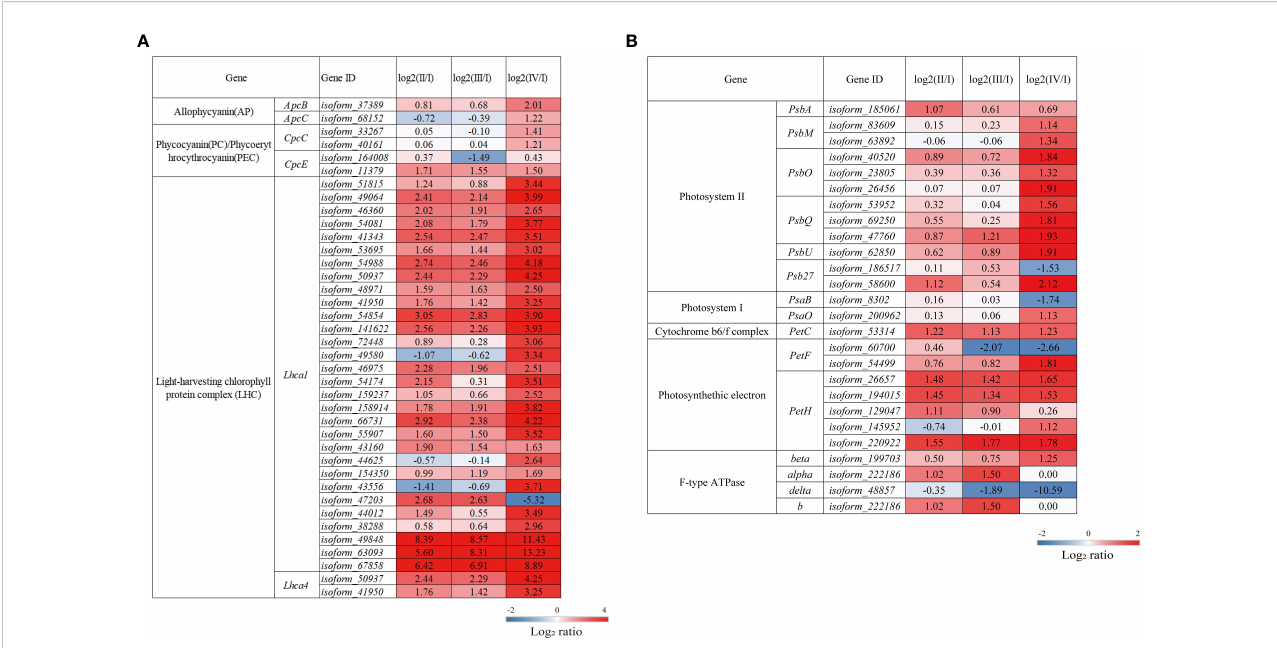
FIGURE 6 The transcriptomic changes in genes associated with photosynthesis-antennal proteins. (A) and photosynthesis (B) in the tetraspore formation of G. lemaneiformis between different phases. Red and blue gradients indicate the upregulation and downregulation of unigenes with the adjusted p value <0.001 and |log2ratio| > 1, separately, while white represents no signi fi cant